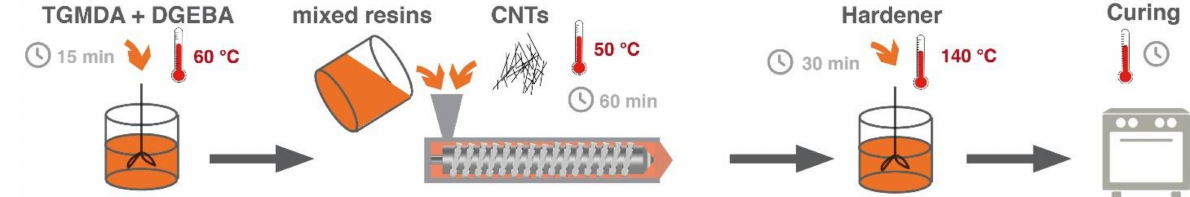
Figure 2. Production steps of neat and (multi-walled carbon nanotube) MWCNT-modified cured